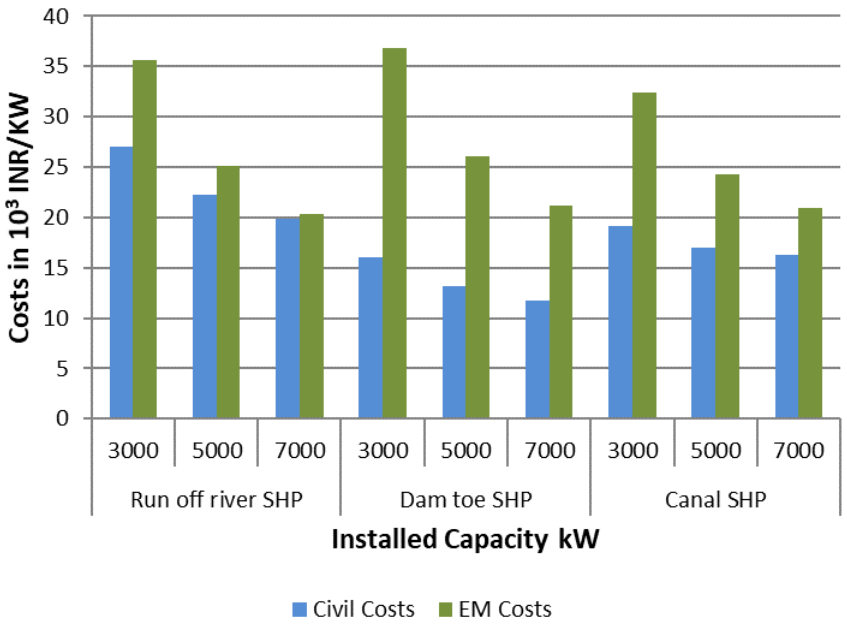
Figure 2. Cost of civil works vs. electro-mechanical components for low head SHP.